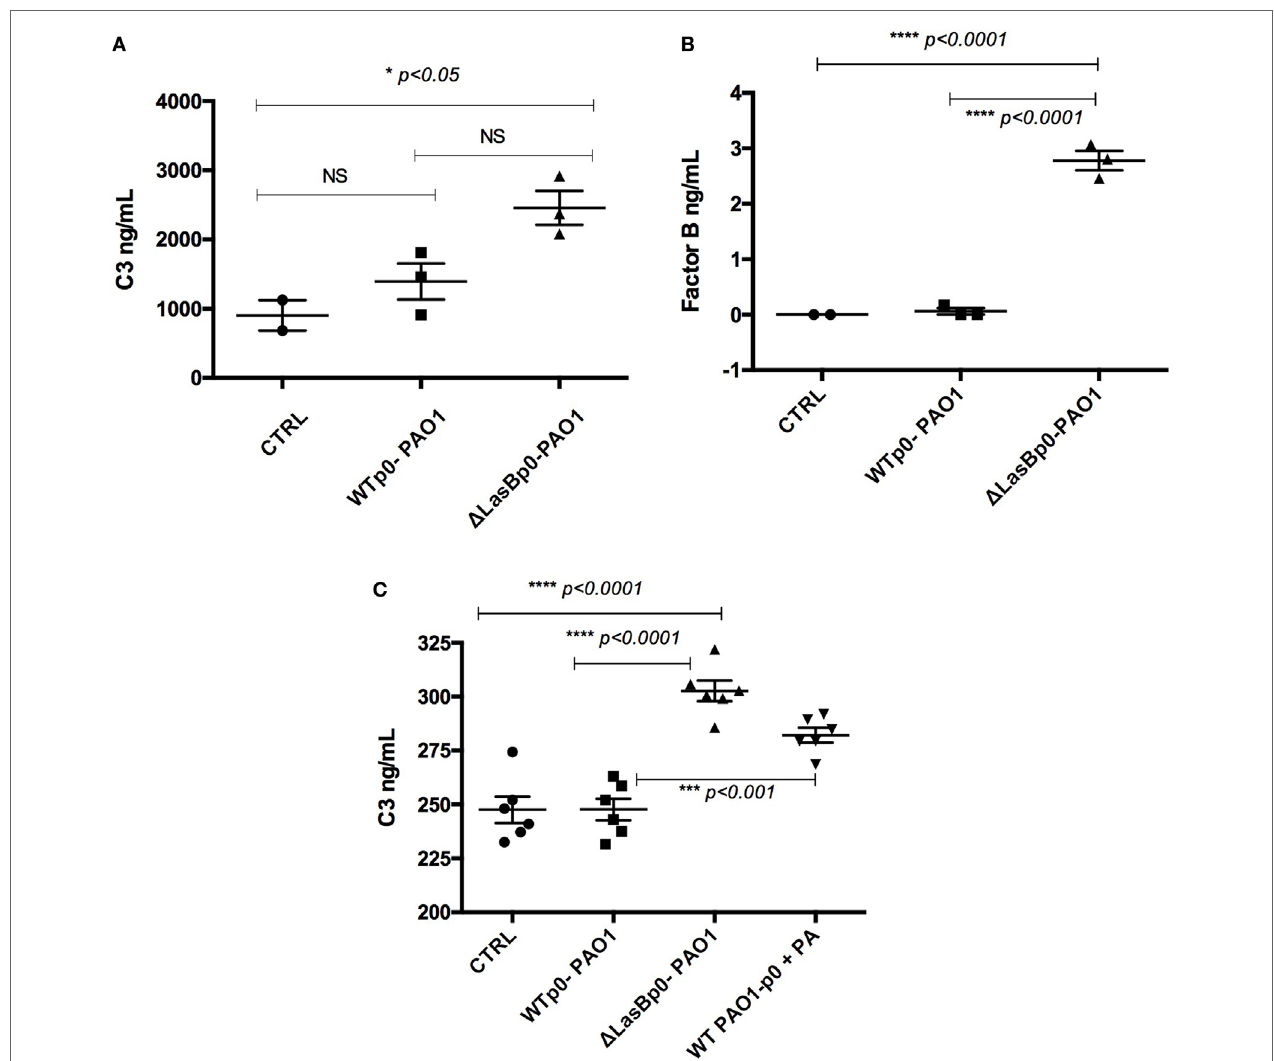
FigUre 9 | Measurement of C3 and factor B levels in MPI supernatants following WT- or Δ LasBp0-PAO1 infection. (a,B) “Proteomics experiment”: the same supernatants used for the Proteomics analysis (see Figure 6 ) were analyzed by enzyme-linked immunosorbent assay (ELISA) for C3 (a) and factor B (B) content. Results are expressed as mean ± SEM, and analyzed with one-way ANOVA, followed by Tukey’s post-analysis. (c) Independently of (a,B) , MPI cells ( n = 3) were either left uninfected (CTRL) or infected (see legend of Figure 4 ) during 4 h with either WT- + p0- or Δ LasB- + p0-PAO1 (moi = 1), in the presence or not of phosphoramidon (PA) (10 µM). Supernatants were then harvested and analyzed by ELISA for C3 content. Results are expressed as mean ± SEM, and analyzed with one-way ANOVA, followed by Tukey’s